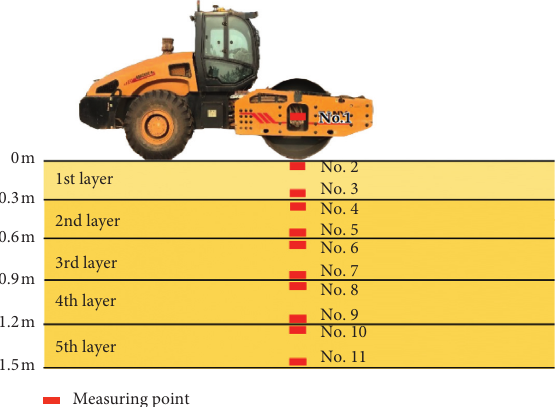
Figure 6: Acceleration measuring points in the filler material.